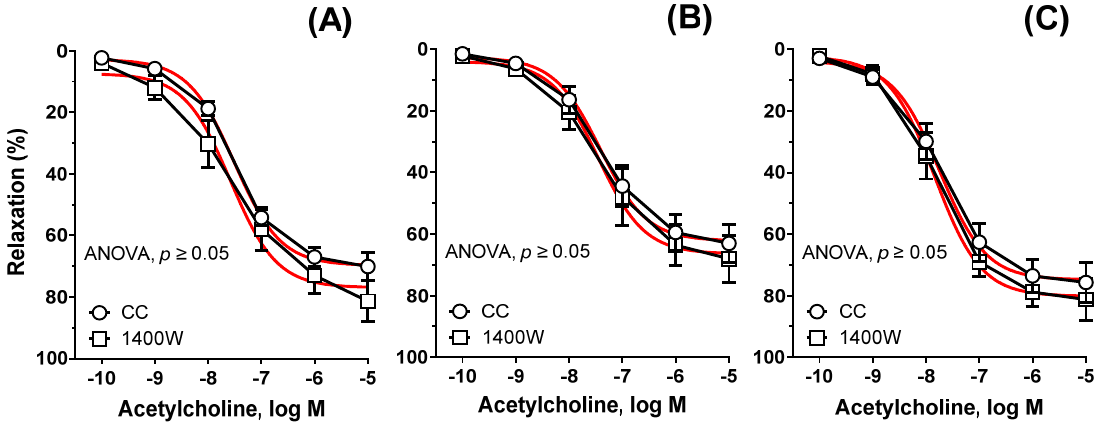
Figure 4. The influence of 1400 W on the relaxant response to acetylcholine. Aortic rings from rats supplemented with Cu 6.5 ( A ), NP 3.25 + Cu 3.25 ( B ), and NP 6.5 ( C ) were pre-incubated with the inducible nitric oxide synthase inhibitor (1400 W, 30 min, 1 µM). Results are means ± SEM, p > 0.05 of n = 5 rats; two-way ANOVA/Sidak’s. Preincubation with the selective iNOS inhibitor did not modify the vasodilation.